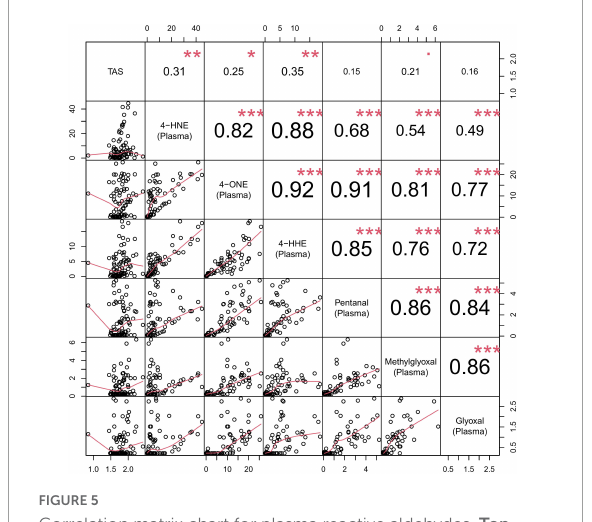
FIGURE5 Correlation matrix chart for plasma reactive aldehydes. Top right –the (absolute) value of the correlation (R) using Spearman’s rho with stars of significance. Bottom left –the bivariate scatterplots, with black circles indicating points and red fitted line. Correlations ≥ 0.7 were considered significant. Stars of significance *** p < 0.001.